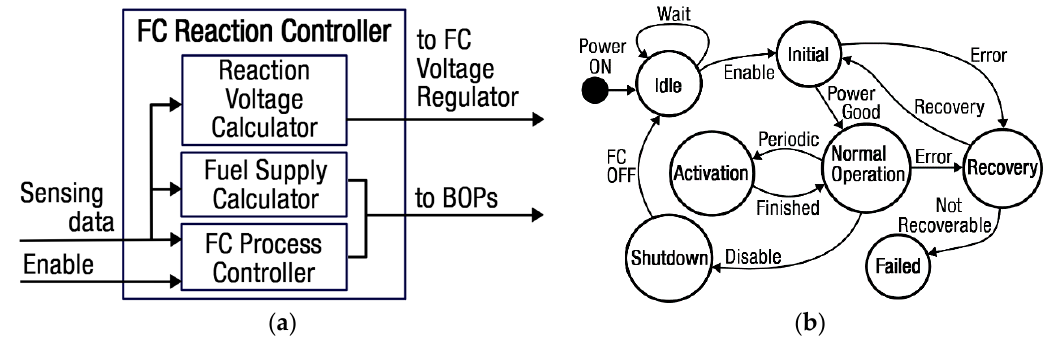
Figure 5. ( a ) Functional block diagram of an FC reaction controller; ( b ) the state machine of the FC process controller.